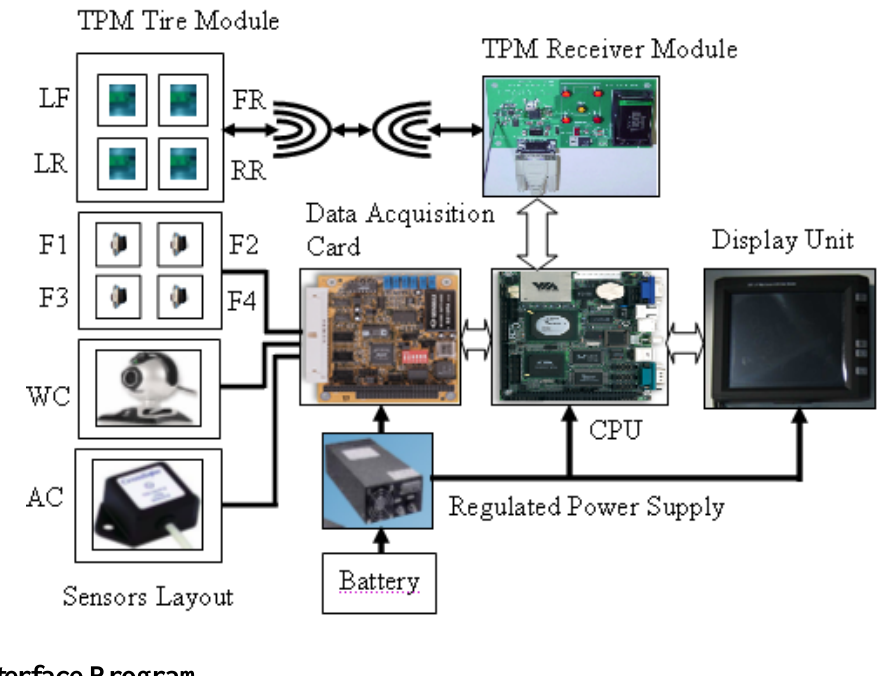
Figure 2. Integrated prototype system